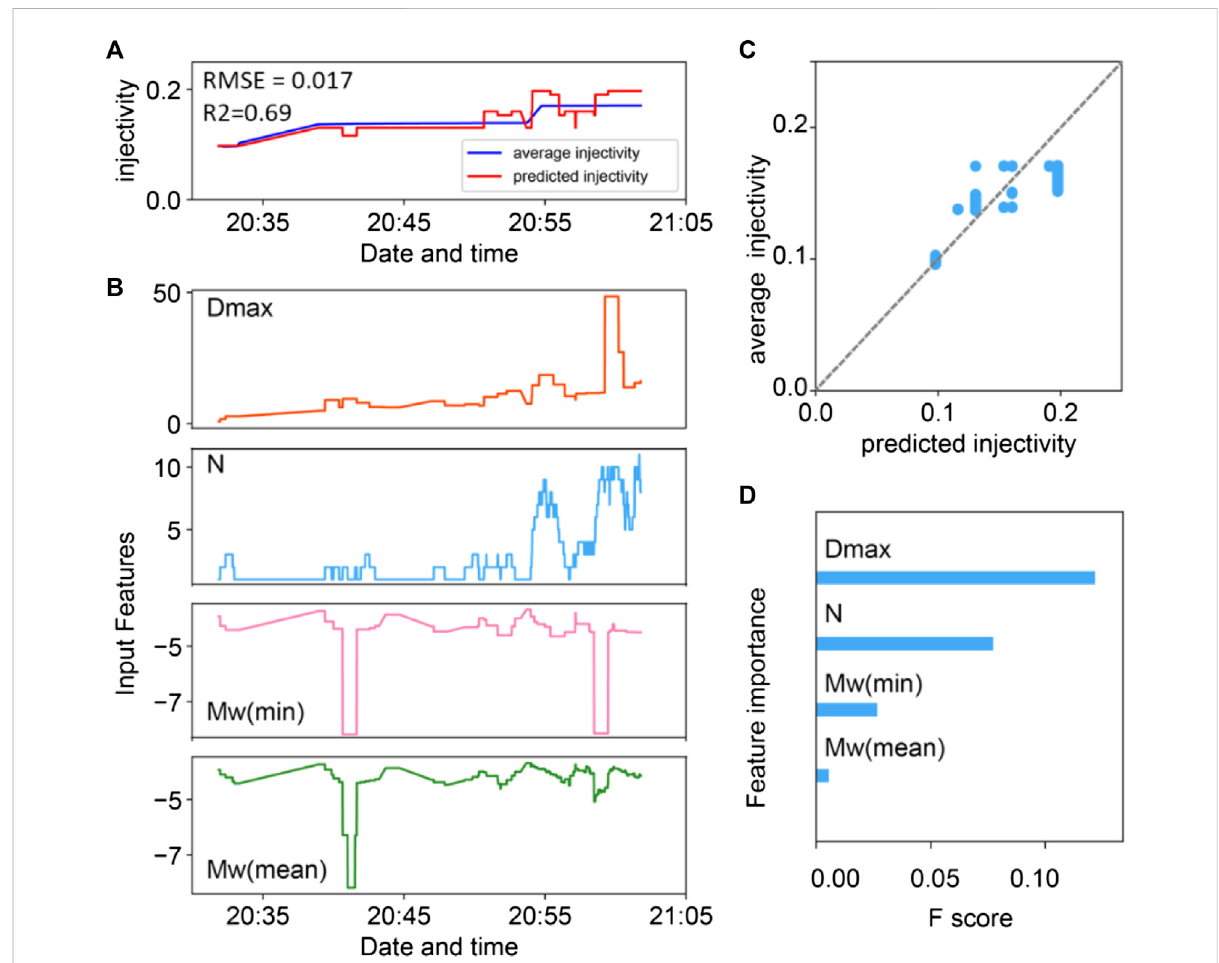
FIGURE 5 Predicted injectivity of episode #4. (A) Average injectivity by time moving window (blue line) and predicted injectivity (red line) from the ML model in episode #5. (B) The input features used to construct the machine learning model. (C) Average permeability vs predicted permeability in episode #5. (D) The importance of input